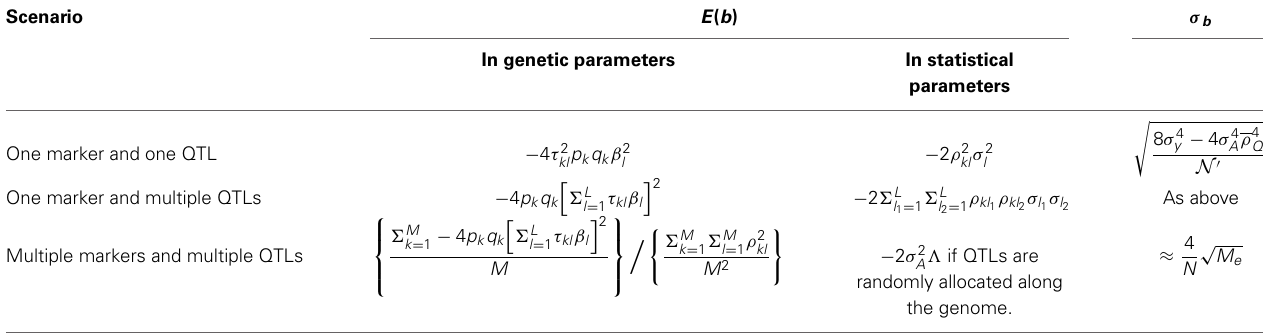
In genetic parameters In statistical